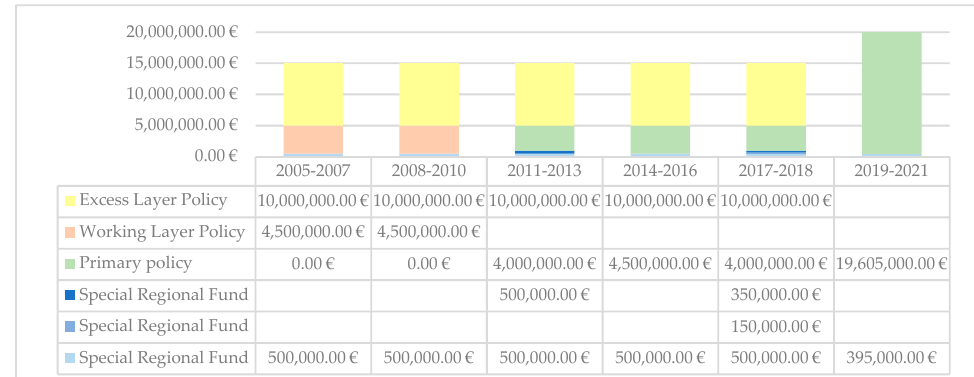
Figure 2. Maximum amount for a single claim.